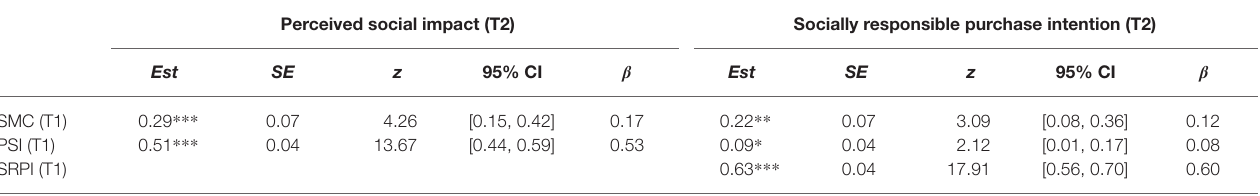
TABLE 2 | Results of path analyses of the hypothesized